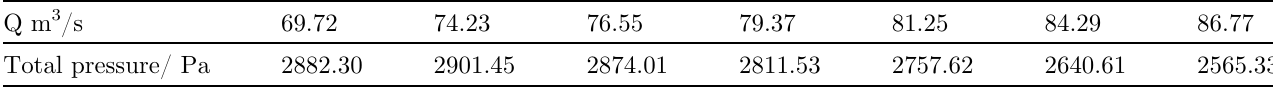
Table 2. Performance parameter values converted to rated speed and standard ventilation state. Q m 3 /s